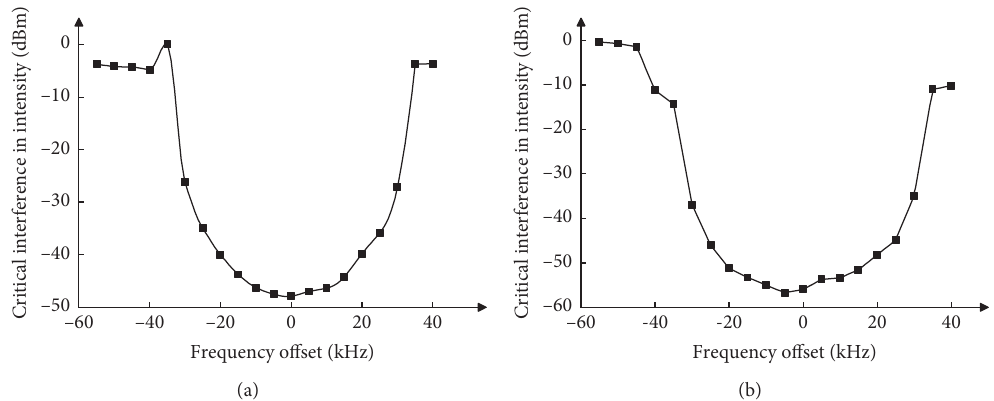
Figure 6: Single-frequency susceptibility of the communication station under test. (a) The communication station is working at 80MHz. (b) The communication station is working at 40 MHz. Table 3: Critical interference power when the communication station is working at 80MHz. Single-frequency critical interference power (dBm)